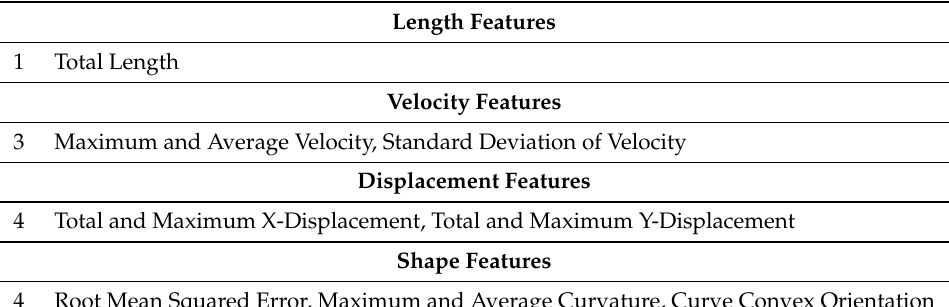
Table 1. Features extracted from touchscreen trace